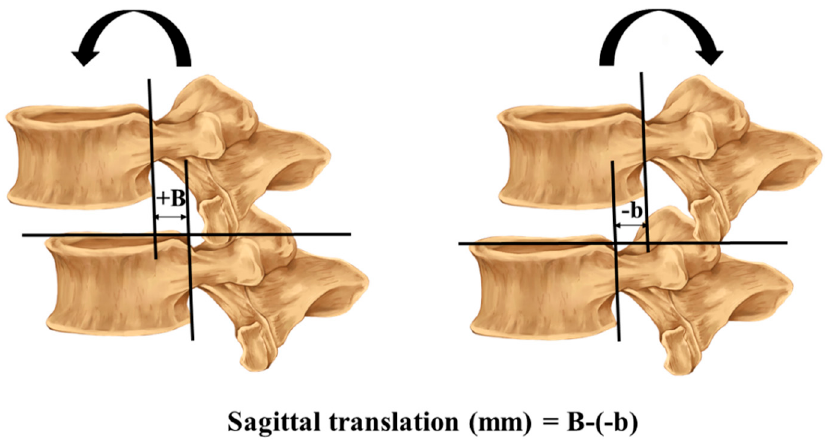
Figure 2. Sagittal translation: a horizontal line is drawn passing the superior endplate of the lower vertebra. Two vertical lines are drawn passing the posterior edge of the upper vertebra and lower vertebra. The distance between the two vertical lines is considered during flexion and extension, and the difference between the two distances from flexion and extension is used in the formula to calculate the segmental translation.